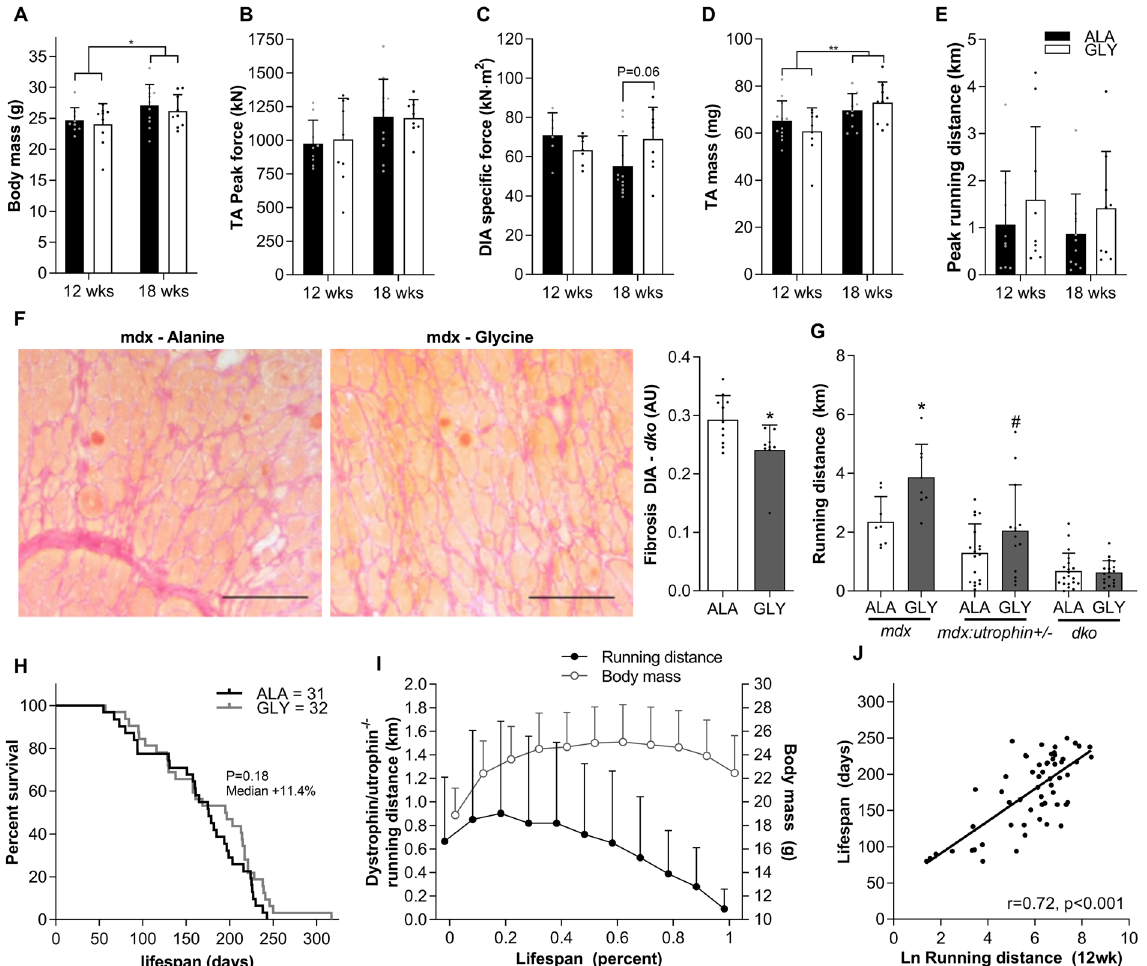
and diaphragm ( C ) muscle function, TA mass ( D ) and voluntary running distance ( E ). Representative muscle cross-sections stained with Van Gieson’s to visualize collagen and its quantification from dko mice after chronic treatment with glycine ( F ). Scale bar represents 100 µ m. Voluntary running distance in mdx , mdx:utrophin + / − and dko treated with either glycine or L-alanine for 2 weeks ( G ). Survival curve of L-alanine and glycine- treated dko mice ( H ); changes in running distance and body mass throughout the lifespan of dko mice ( I ); and correlation (Pearson’s r) between lifespan and the natural logarithm of running distance ( J ). Data in A-E were analyzed using two-way ANOVAs with Sidak’s post hoc test. Two-group comparisons were made using students t-tests, which lifespan curves were compared using a log-rank Mantel-Cox test. Data are mean ± SD of at least 8 mice per